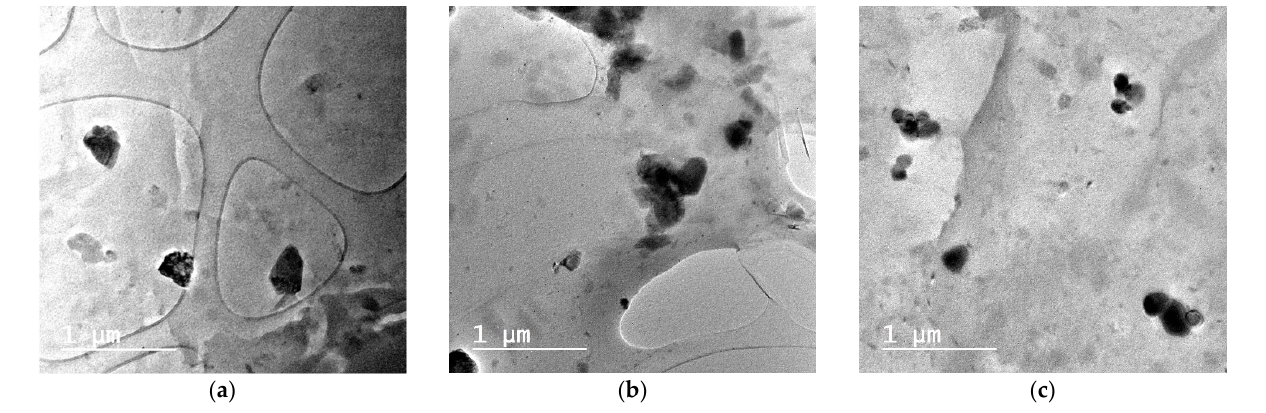
Figure 2. TEM micrographs of PBSu/biochar composites fi lled with ( a ) 1 wt.% biochar, ( b ) 2.5 wt.% biochar and ( c ) 5 wt.% biochar. biochar and ( c ) 5 wt.%